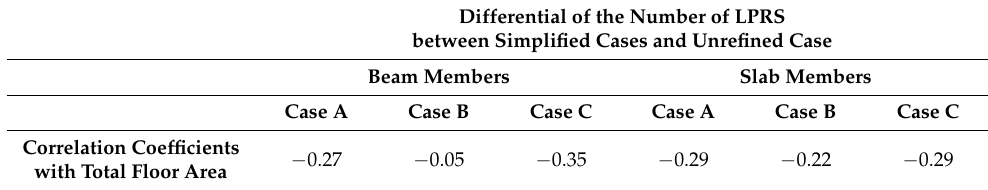
Table 11. Correlation analysis between the results of the simplifications and total floor